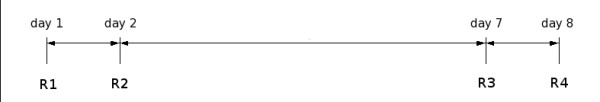
Study design. Blood samples were collected in four survey rounds (R1-R4), on day 1, 2, 7 and 8. The result of this study design are two sampling intervals of 1 day, one of 5, two of 6, and one of 7 days. A 48-hour periodicity of P. falciparum detectability could therefore be identified, as it should show positive correlation of detection outcomes between surveys with even-numbered interval length, and negative correlation between surveys with odd-numbered interval length (in days).